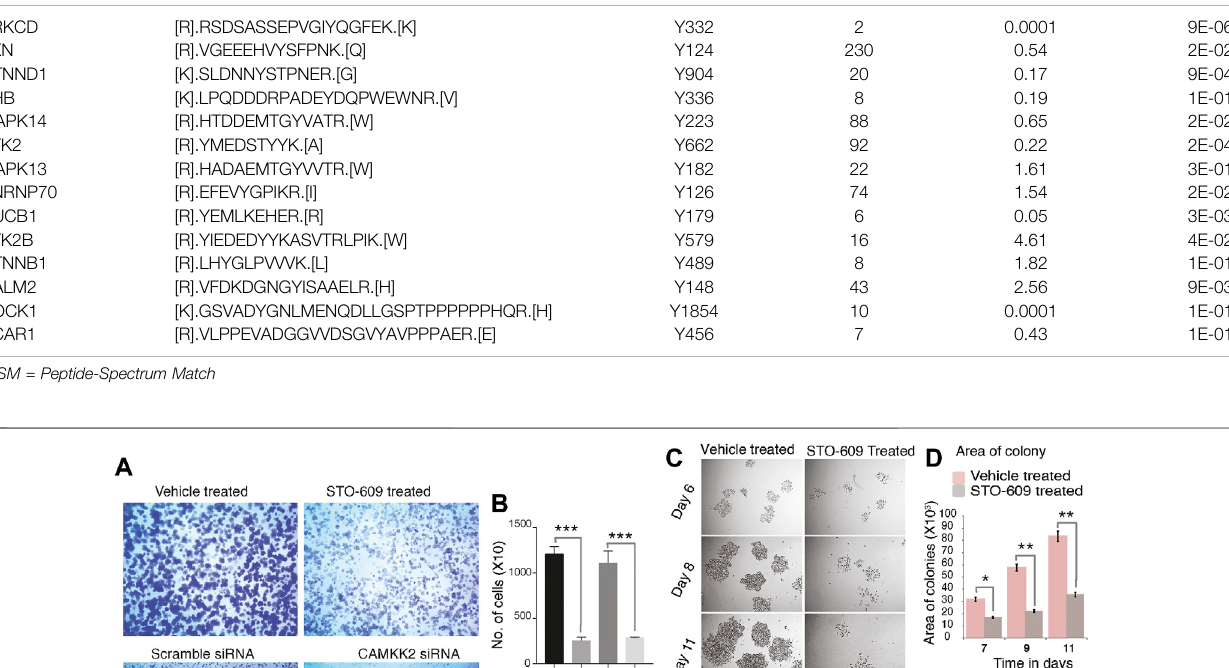
TABLE 4 | List of signi fi cantly hypo-phosphorylated (tyrosine) proteins upon inhibition of CAMKK2 involved in VEGF and VEGFA – VEGFR pathways. Gene Sequence Site PSM a FC(T/C) P-value PRKCD